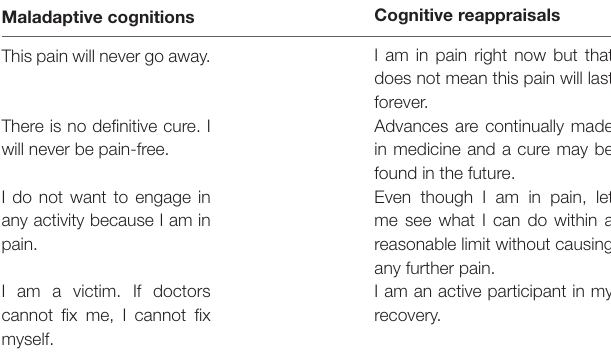
TABLE 1 | Examples of turning maladaptive cognitions into adaptive cognitive reappraisals. Maladaptive cognitions Cognitive